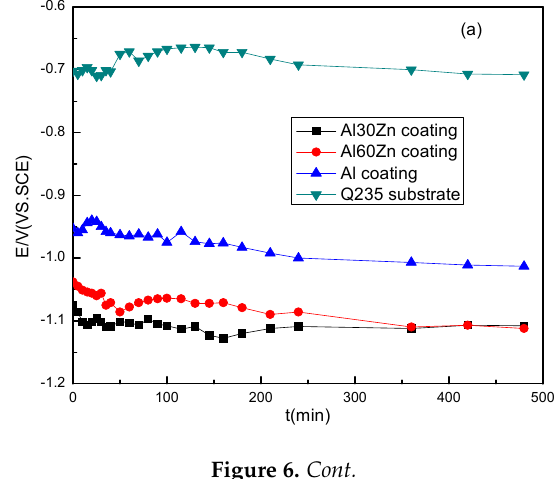
Figure 6. Cont. Figure 6.